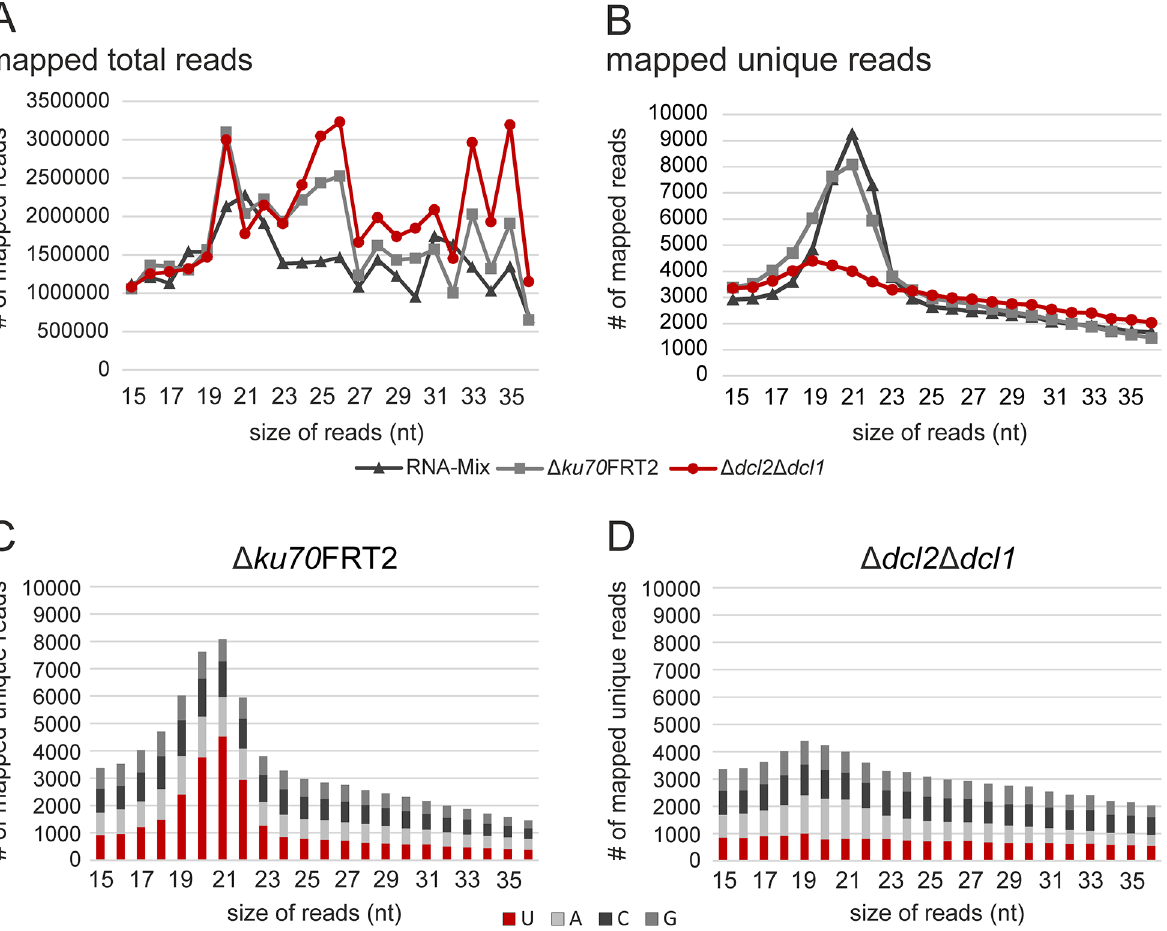
Fig 2. Length distribution of P . chrysogenum small RNA population. Length distribution of mapping sRNA reads for the datasets of total (A) and unique (B) reads obtained from three different samples. Frequency of the 5'-nucleotide of the unique reads of Δ ku70 FRT2 (C) and Δ dcl2 Δ dcl1 (D) in dependency of their read